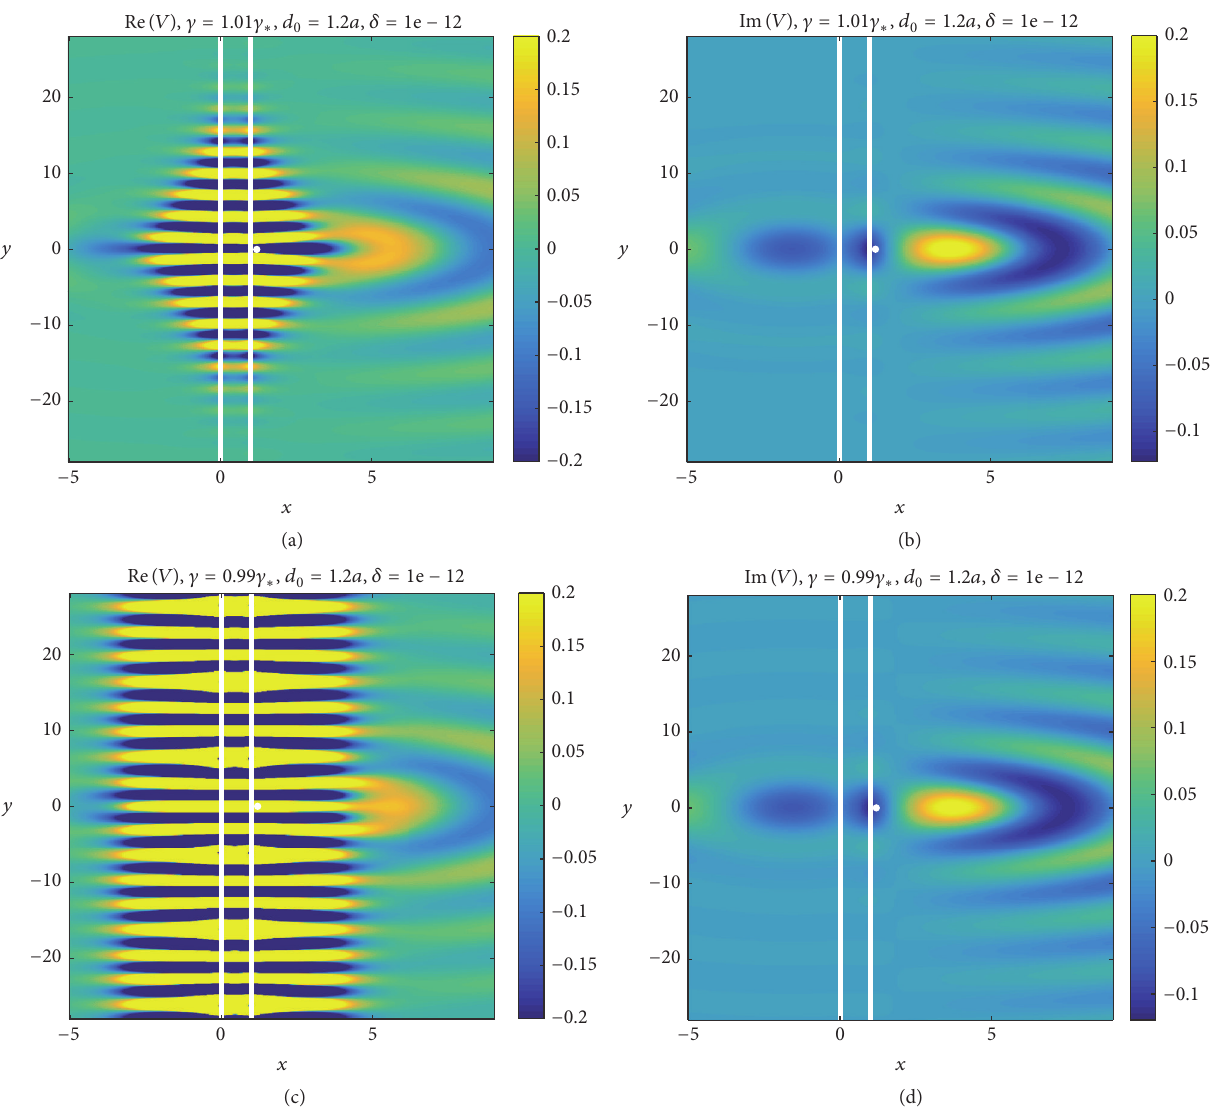
Figure 9: This is a plot of 𝑉 , the solution to (4), when 𝑓 is a dipole located at 𝑑 0 = 1.2𝑎 : (a) Re (𝑉) and (b) Im (𝑉) for 𝛾 = 1.01𝛾 ∗ ; (c) Re (𝑉) and (d) Im (𝑉) for 𝛾 = 0.99𝛾 ∗ . To make the behavior of 𝑉 clearer, in (a), (c), and (d) we clipped the maximum and minimum values in each plot to 0.1 (yellow) and −0.1 (blue),